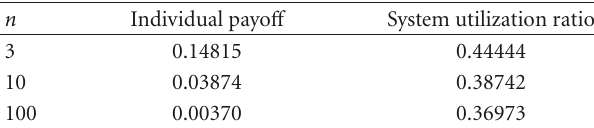
Table 1: Individual payo ff s and system utilization ratios with homogeneous